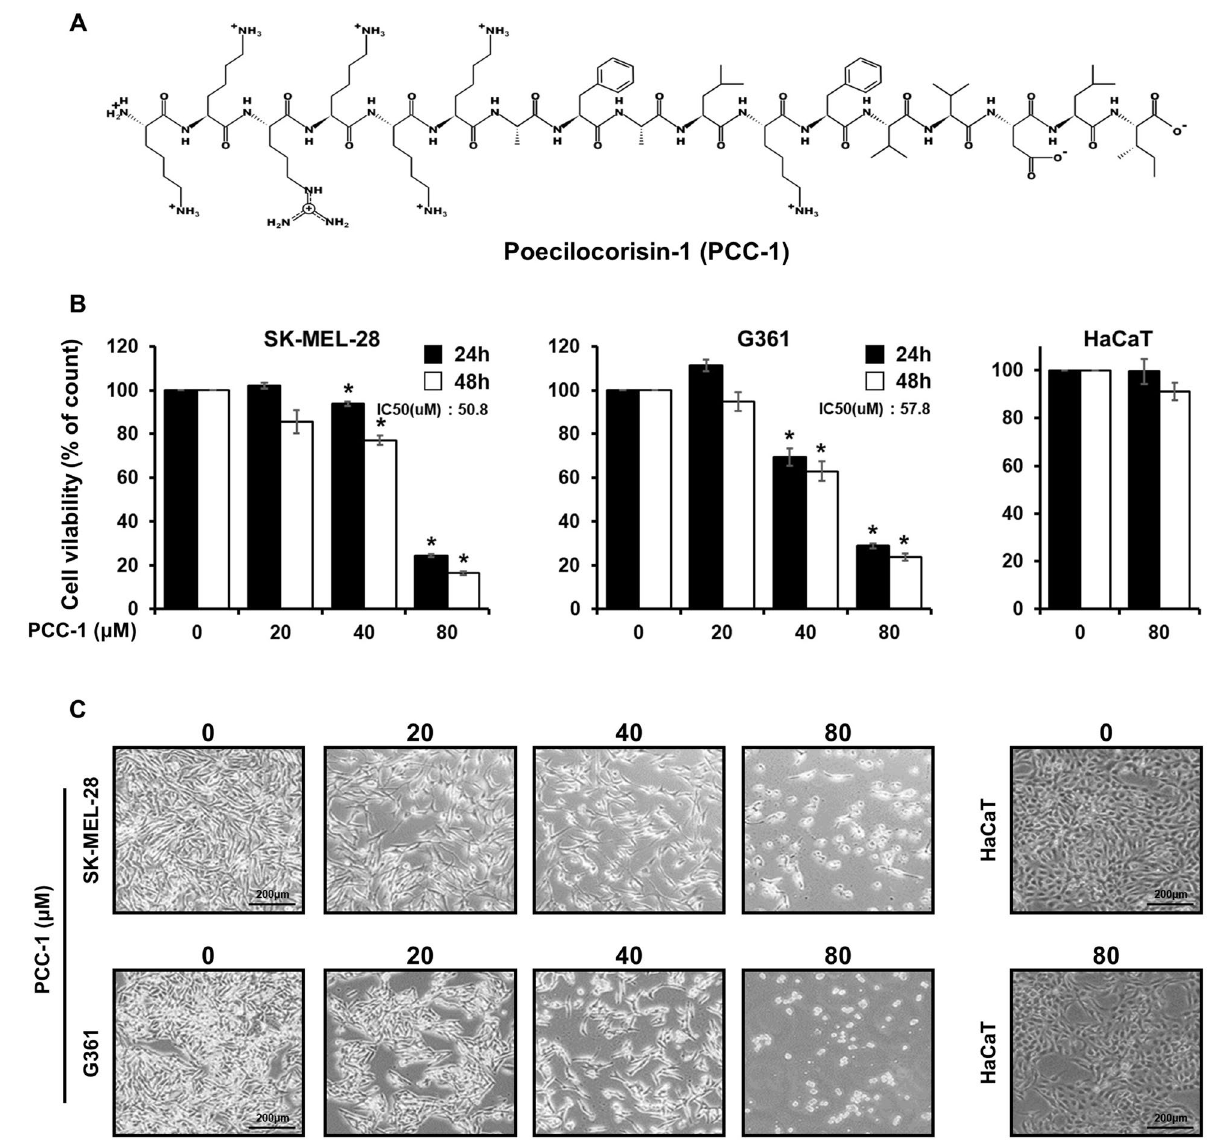
Figure 1. ( A ) Peptide structure of poecilocorisin-1 (PCC-1). ( B ) The cell viability in PCC-1-treated SK-MEL-28, G361, and HaCaT cells (20, 40, and 80 μM) was detected using an MTS assay kit. Data represent the mean ± standard deviation (SD). *Significantly different, as compared with untreated controls, by the paired t test (n = 3; p < 0.05). ( C ) Morphological changes observed in the PCC-1-treated SK-MEL-28, G361, and HaCaT cells (20, 40, and 80 μM) and untreated